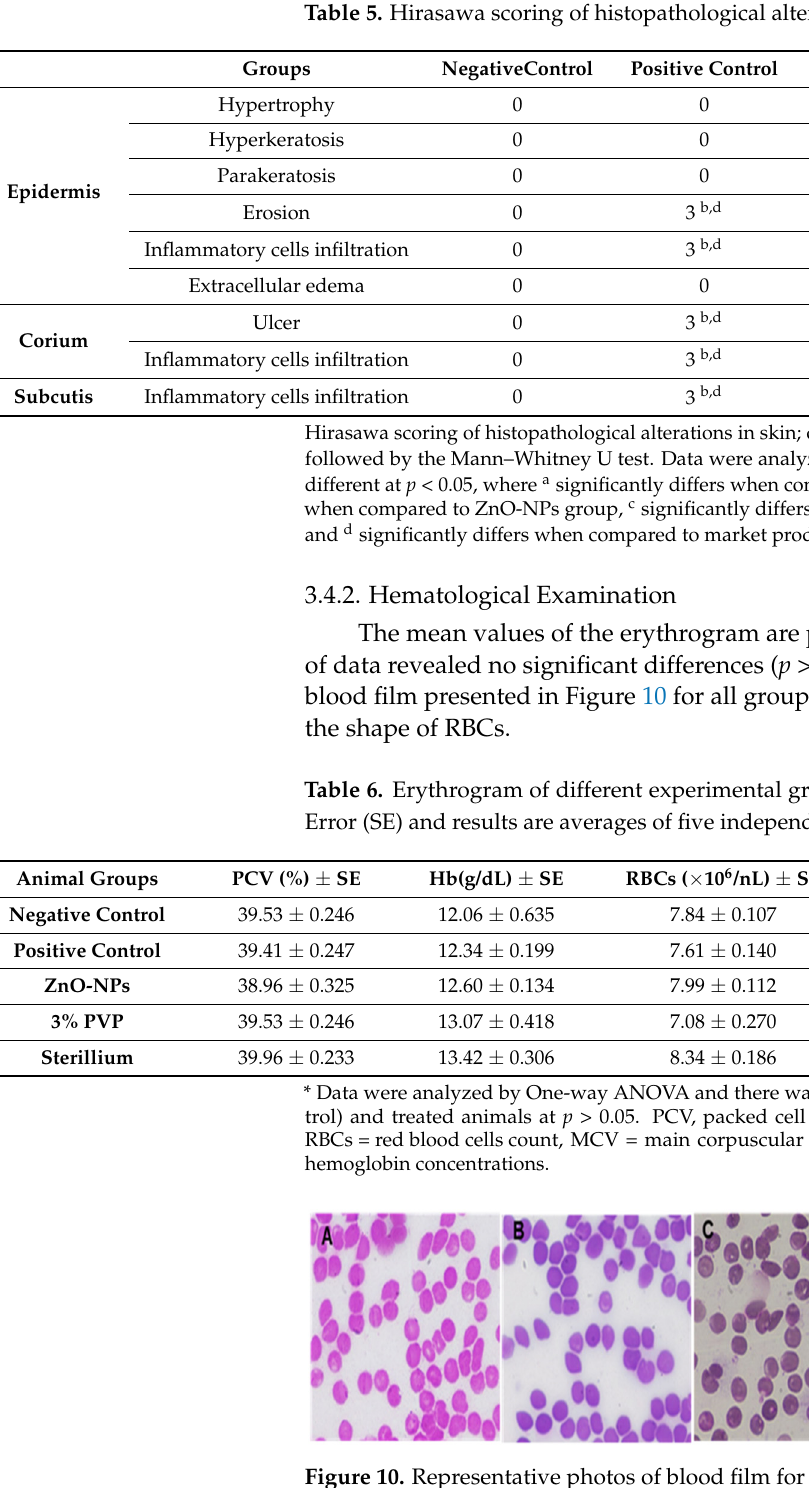
Figure 10. Representative photos of blood film for one representative rat blood film of ( A ) Group I (negative control, shaved animal skin was not swapped with S. aureus, with no samples